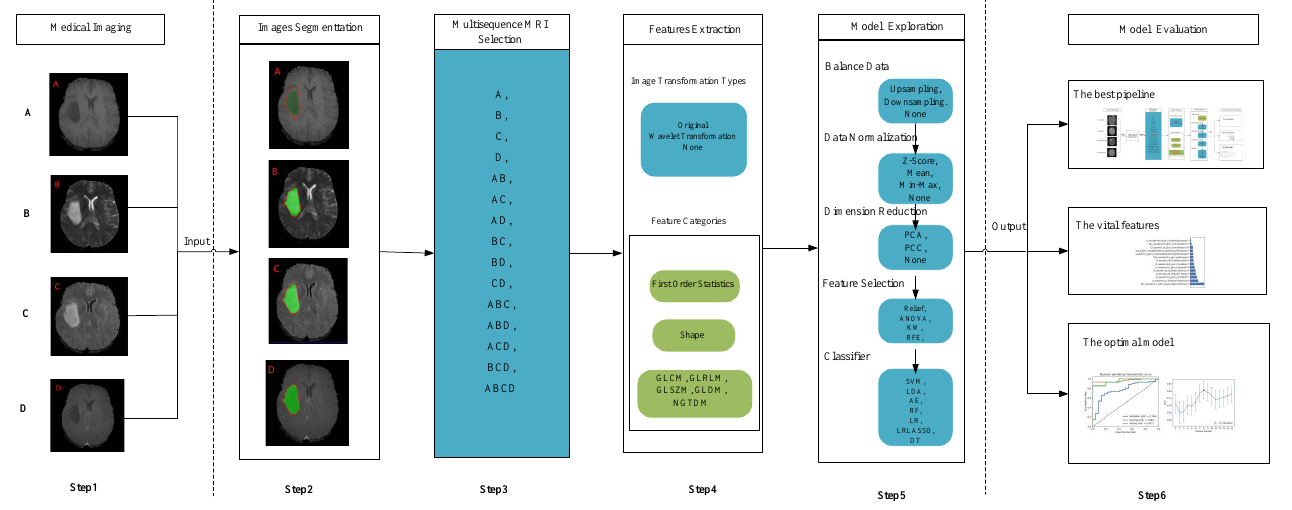
Figure 2. Flow chart of the “6-Step” general radiomics model. The data frames in blue indicate that we chose one of the displayed methods, and the data frames in green mean that we chose all of the displayed methods. A, B, C, and D indicate different medical images. The “+” symbol indicates that different MRI sequences were combined to form a new input object. Abbreviations: GLCM, Gray- level co-occurrence matrix; GLSZM, Gray-level size zone matrix; GLRLM, Gray-level run length matrix; GLDM, Gray-level dependence matrix; and NGTDM, neighboring gray tone difference ma- trix.